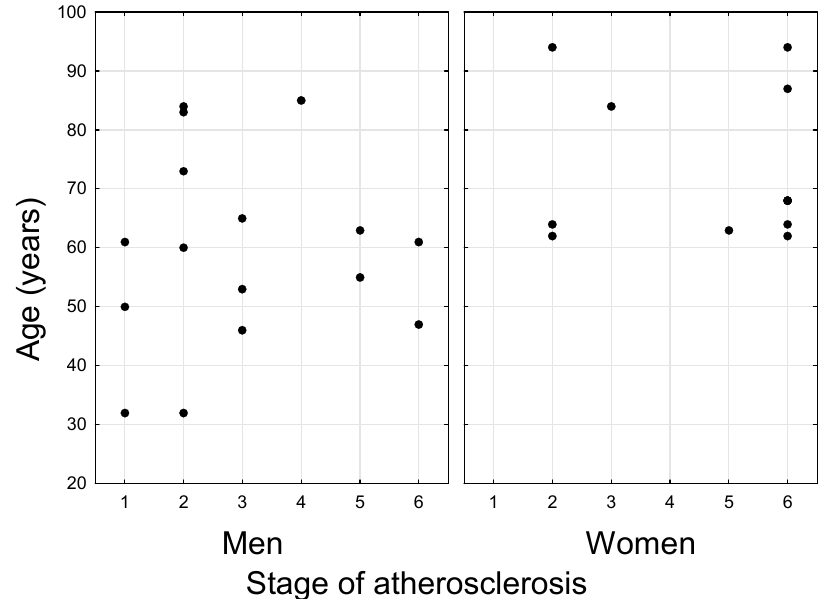
Figure 1. Sample distribution depending on the age of the donor and the severity of atherosclerosis in the aortic sample.